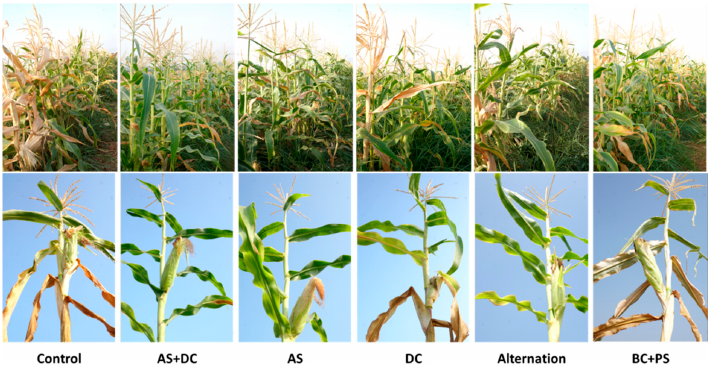
Figure 3. Late wilt disease symptoms in representative plants (Amir, summer 2018). Prelude cultivars’ samples from the field experiment were collected arbitrarily and photographed 71 DAS, 16 DAF. Dehydration symptoms include drying out spreading upwards in the plant, including leaf, stem, and cobs yellowing.